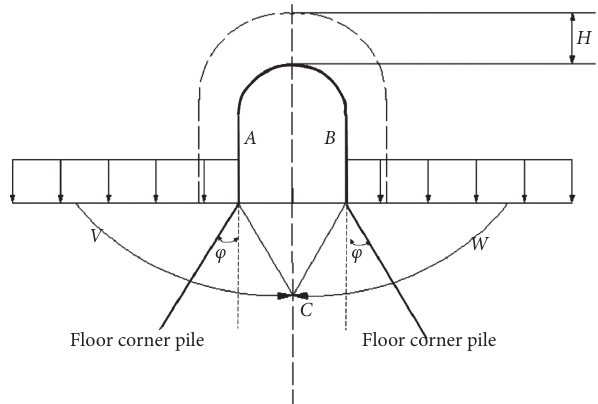
Figure 1: The mechanical model of roadway floor corner